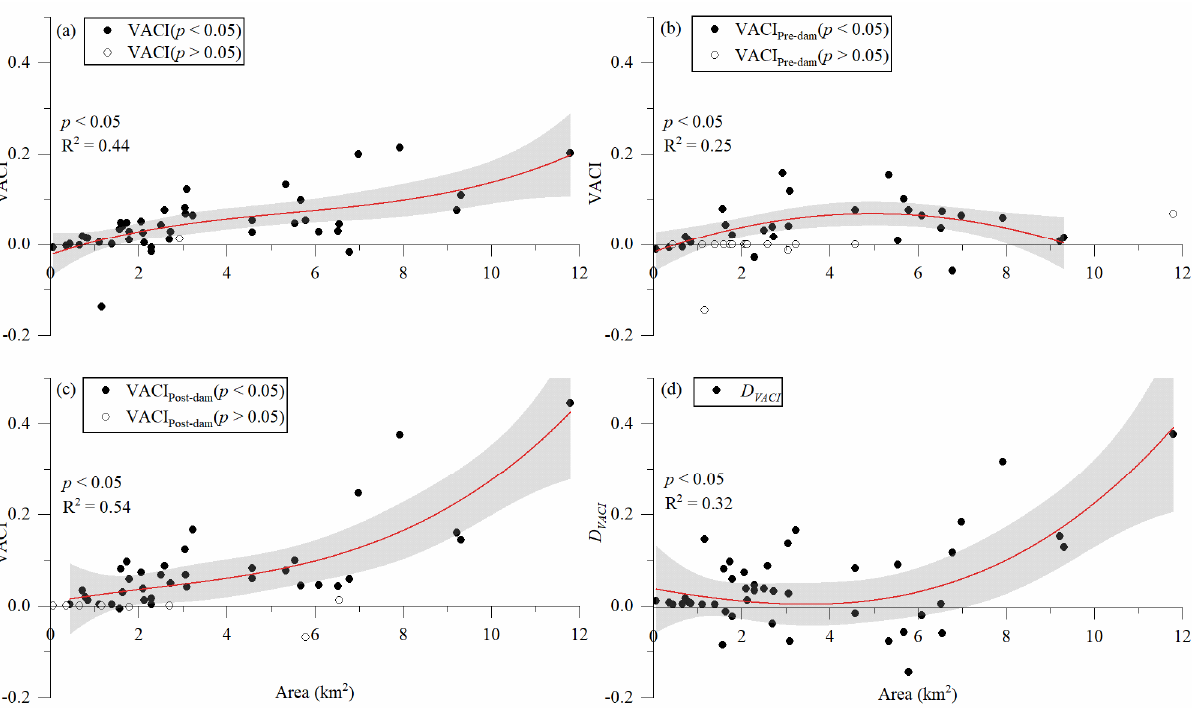
Figure 5. The relationships between VACIs of individual MCBs and MCBs’ sizes in the three distinct periods. ( a ) For whole period: 1987–2017; ( b ) for pre-dam period: 1987–2002; and ( c ) for post-dam period: 2003–2017. ( d ) For the difference of VACIs in post- and pre-dam period. The shaded areas are 95% confidence intervals.